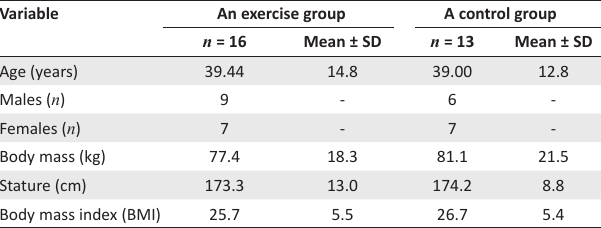
TABLE 2: Description of the participants ( n = 29).